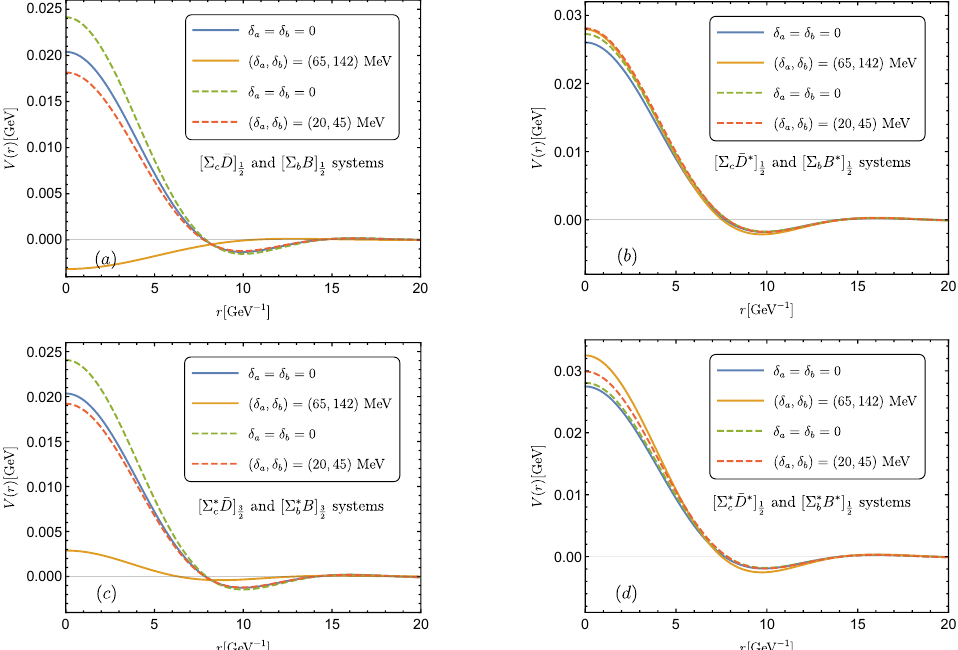
Figure 14 . The heavy quark symmetry breaking phenomena in the two-pion-exchange diagrams. The solid lines denote the (cid:6) ( (cid:3) ) c (cid:22) D ( (cid:3) ) systems with vanishing mass splittings and physical mass split- tings. The dashed lines represent the same cases but for the (cid:6) ( (cid:3) ) share the similar behaviors as their spin